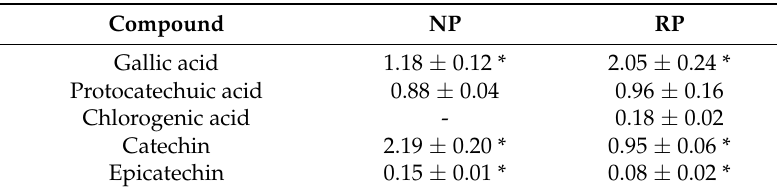
Table 1. Flavonoids and phenolic acids in NP and